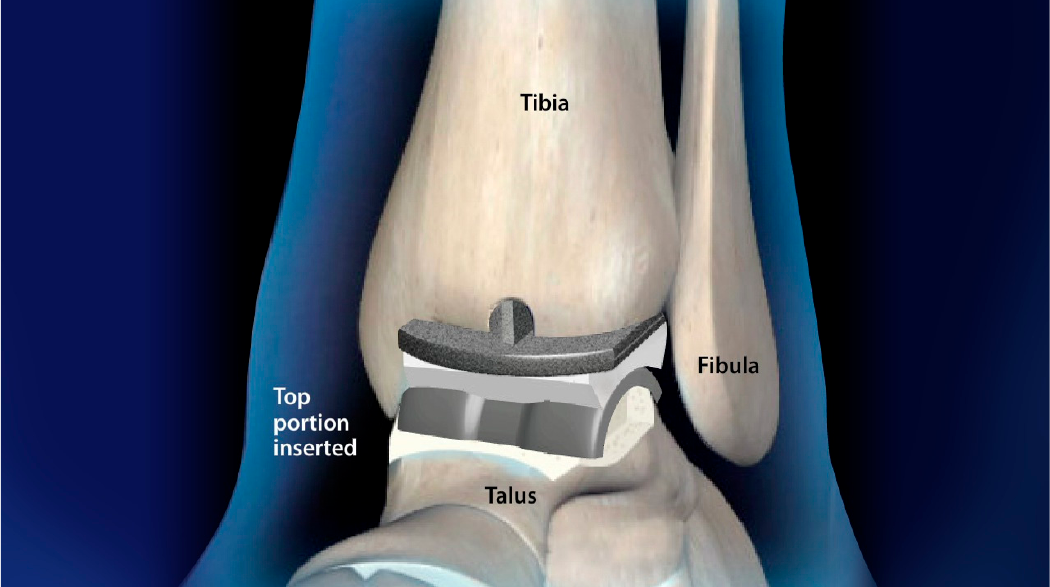
Figure 3. Rendering of the Salto Talaris total ankle replacement system, which is a fixed bearing